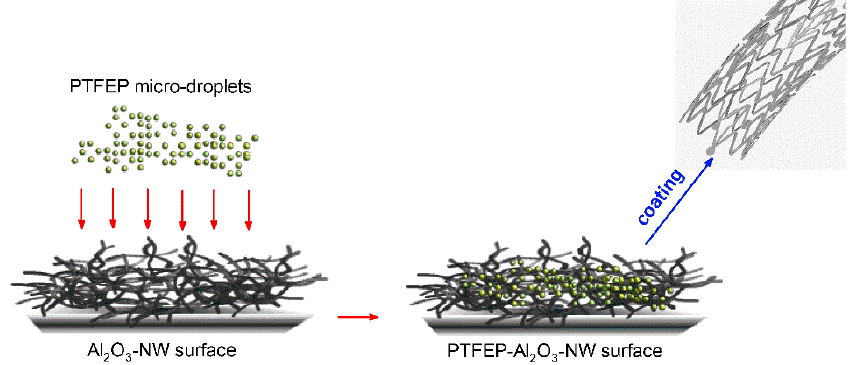
Figure 23. Hydrophobic polyphosphazenes. Acknowledgments: Dedicated to Mario Gleria, the friend who disclosed us the rainbow of phosphazenes. Funding: This research was funded by the Department of Industrial Engineering, University of Padova (Italy), SID Project 2022. Conflicts of Interest: The authors declare no conflict of interest. References